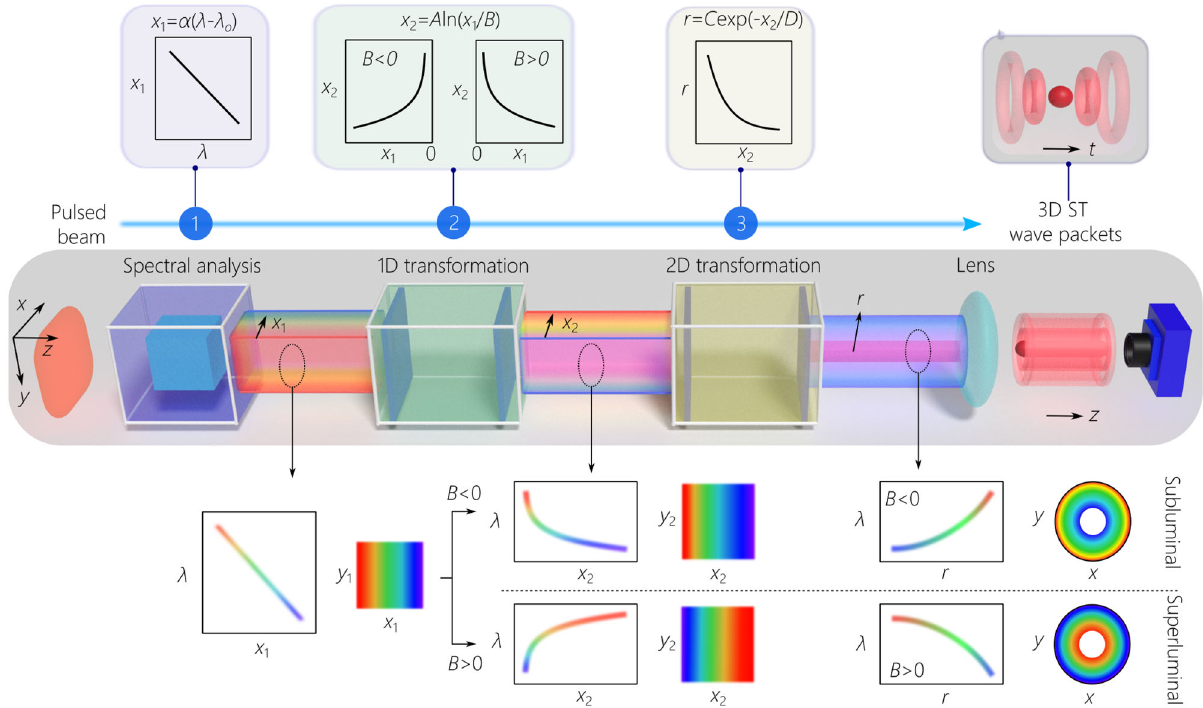
Fig. 3 | Schematic of the setup for synthesizing 3D ST wave packets. Starting withaplane-wavepulseontheleft,spectralanalysisresolvesthespectruminspace and produces linear spatial chirp, x 1 ( λ )= α ( λ − λ o ). The spectrally resolved fi eld entersatunable1D spectraltransformationformedoftwospatiallightmodulators `reshuf fl es' the wavelengths, x 2 ð λ Þ = A ln ð x 1 ð λ Þ B Þ . Opposite signs of chirp along x 2 are required for subluminal and superluminal wave packets. Next, a fi xed 2D